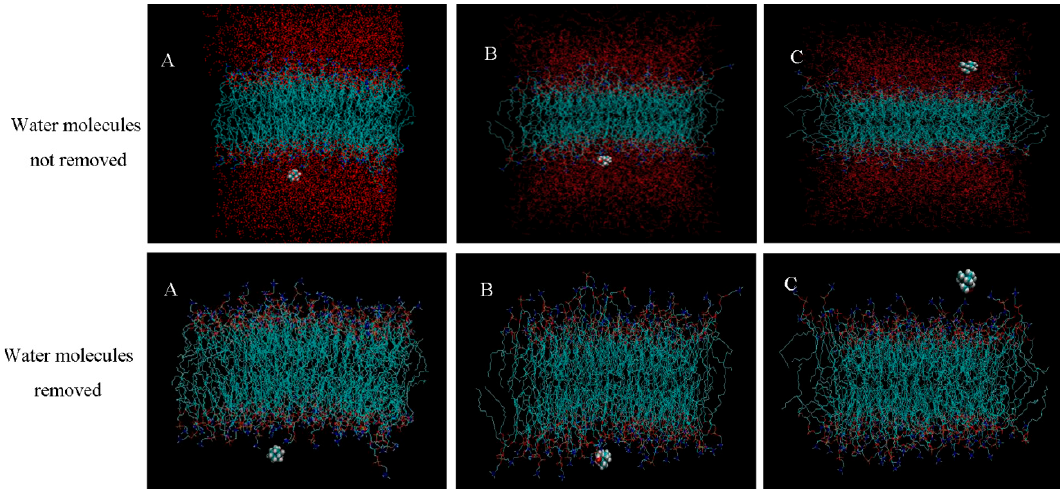
Figure 6. The simulated location of triptolide: ( A ) the initial location of the new system; ( B ) triptolide in contact with the phospholipid layer; ( C ) system diagram at the last moment.